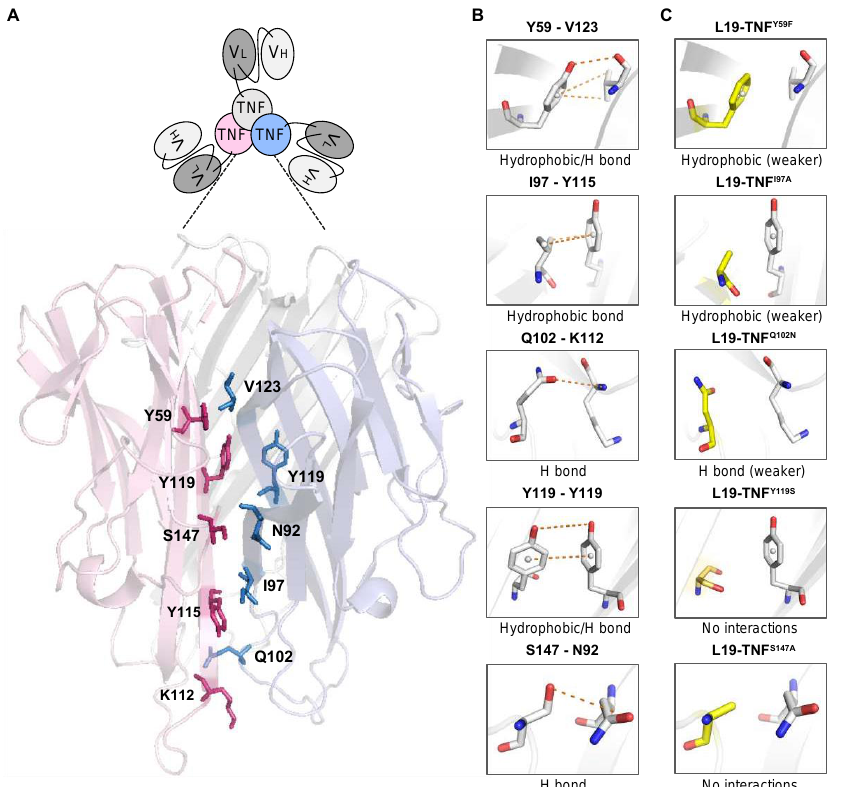
Figure 1. Graphical representation of the most relevant TNF monomer-monomer surface interactions in L19-TNF. ( A ) Scheme of the Fibromun product and 3D structure of the interaction surface between TNF monomers. ( B ) Side chains of amino acids involved in non-covalent interactions between TNF subunits. ( C ) List of mutations considered in this article and schematic 3D illustration of the single side chain interactions after mutation by design.